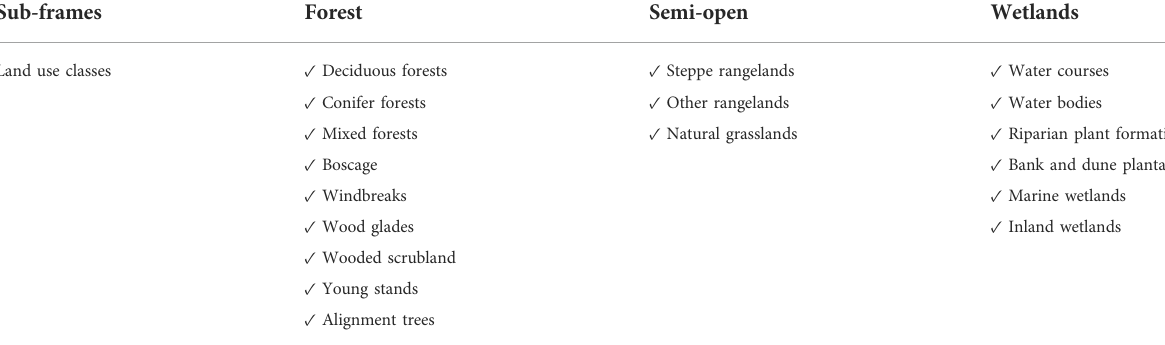
TABLE 2 Sub-frames of the Sousse region and associated land use